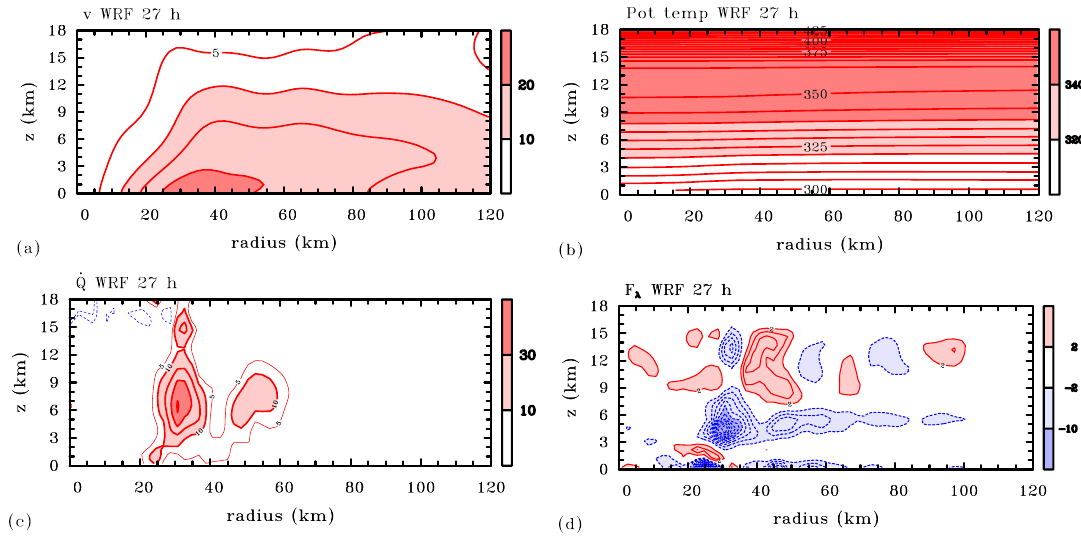
Figure 2. Calculated basic-state circular vortex and corresponding forcing terms as output from the WRF model at hour 27 in the simulation of the intensification of Hurricane Igor (2010). This basic state and these forcing terms (held constant) are used in the integration of the linear 3DVPAS model. Shown are the azimuthally-averaged ( a ) basic-state tangential velocity V at hour 27 (contour interval 5 m s − 1 ); ( b ) basic-state potential temperature Θ at hour 27 (contour interval 5 K); ( c ) diabatic heating-rate forcing ˙ Q at hour 27 (thick contour interval is 10 K h − 1 , thin curve contour interval is 5 K h − 1 ); and ( d ) tangential momentum forcing F λ at hour 27 (contour interval 2 m s − 1 h − 1 , solid positive, dashed